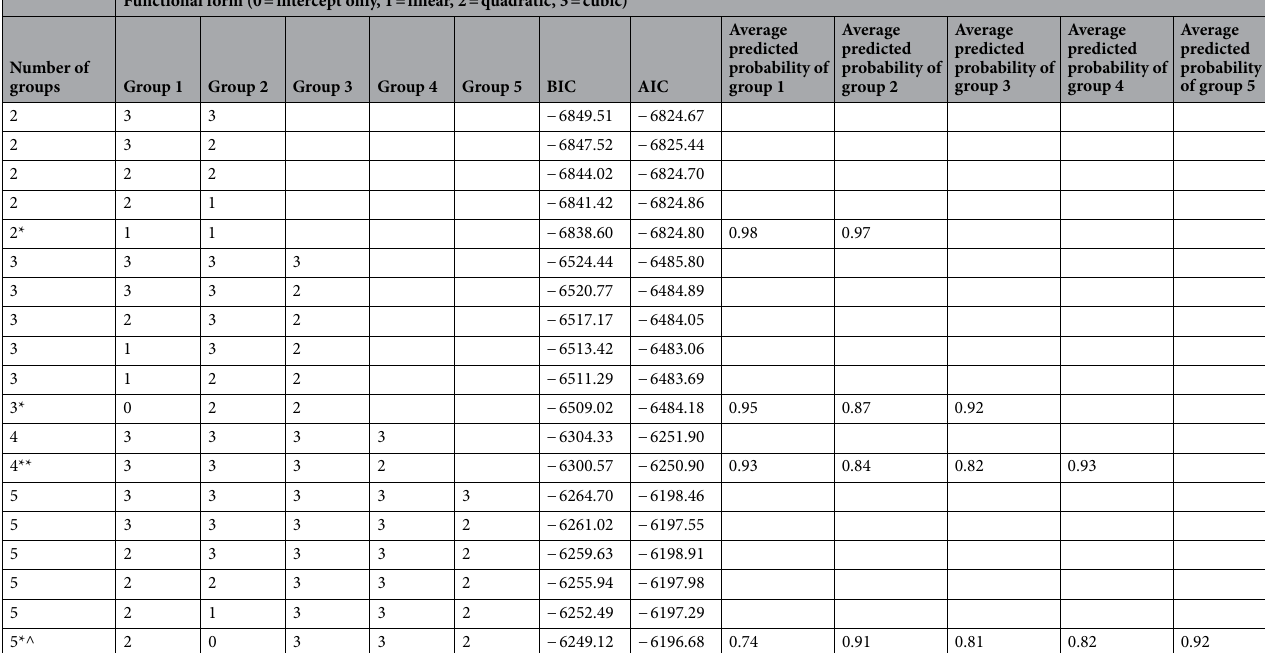
Table 2. Fit statistics for latent class growth analysis of number of depression symptoms in the past 30 days, modeled using a zero-inflated Poisson distribution with different numbers of groups and functional forms